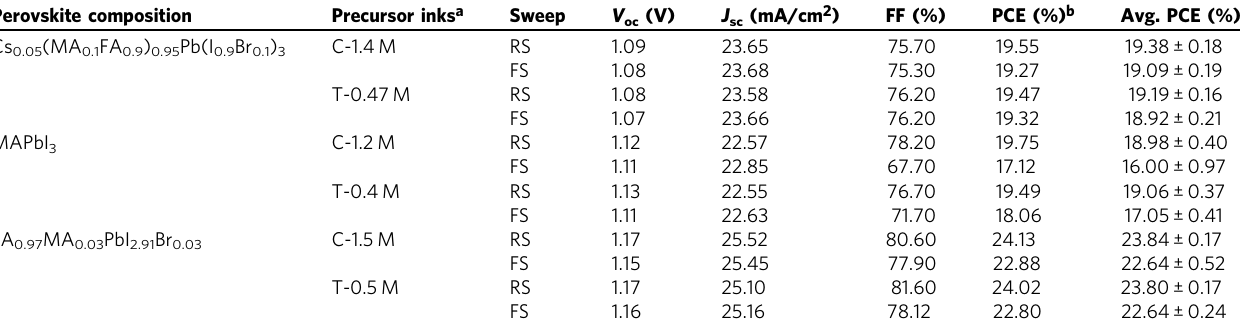
Table 1 Photovoltaic performance of PSCs based on different perovskite compositions with and without co-solvent dilution. Perovskite composition